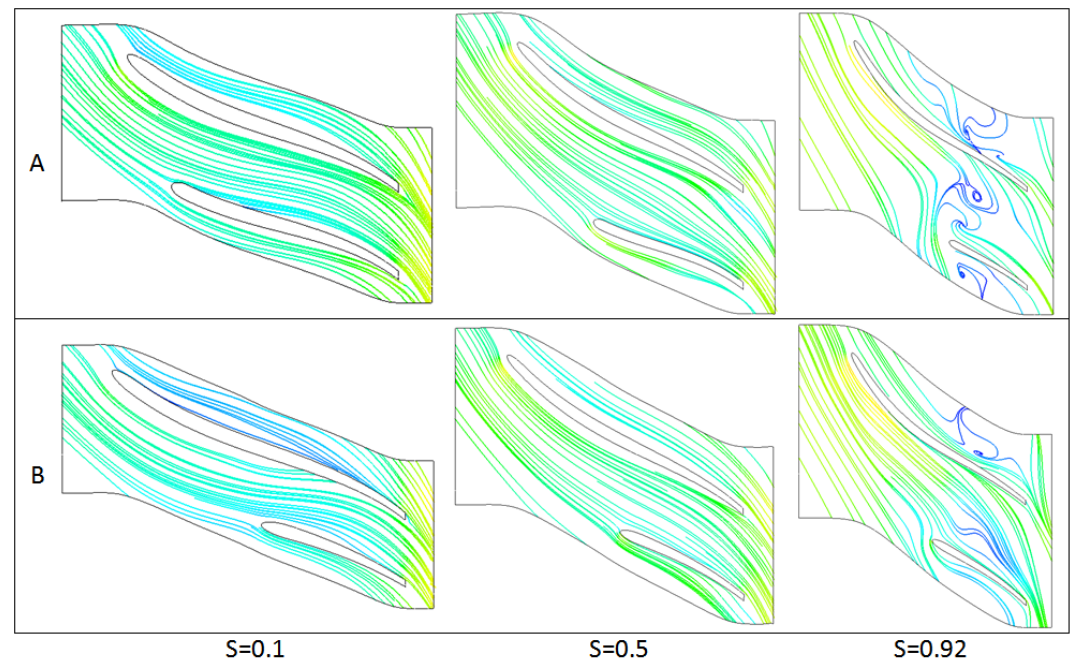
Figure 15. Streamlines of the two cases at different